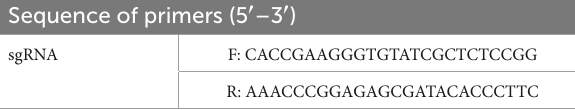
TABLE 1 List of primers for sgRNA